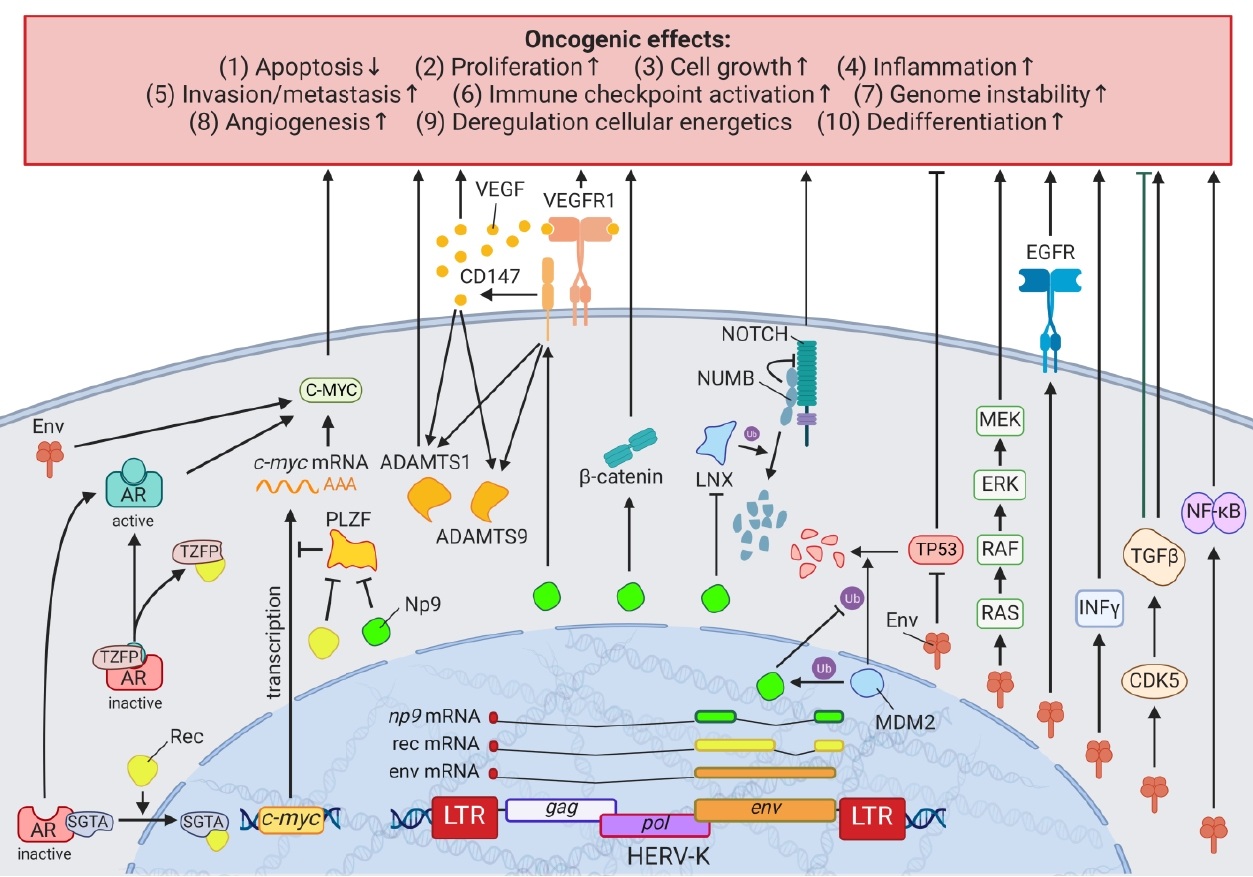
Figure 2. The effects of HERV-K (HML-2) Np9, Rec, and Env proteins on oncogenesis. LTR = long terminal repeat, gag = group antigen (capsid), pol = polymerase, env = envelope, HERV-K = HML-2.